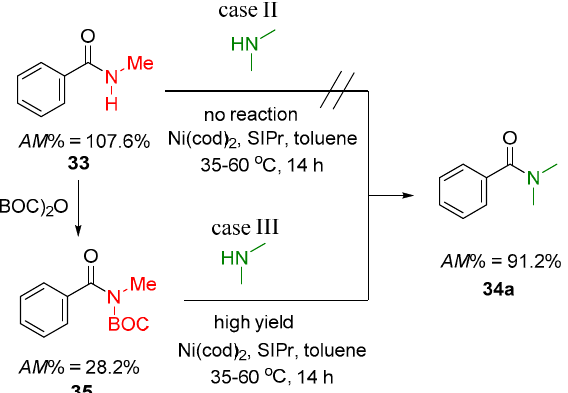
Figure 13. Exemplified transamidation reaction of 33 (case III) with ( 33 → 35 ) and without amide activation. The corresponding amidicity values were computed at B3LYP/6-31G(d,p) level of theory. BOC = t –BuO–CO–; cod = 1,5-cyclooctadiene; SIPr = 1,3-bis(2,6-diisopropylphenyl)imidazole-2-ylide.